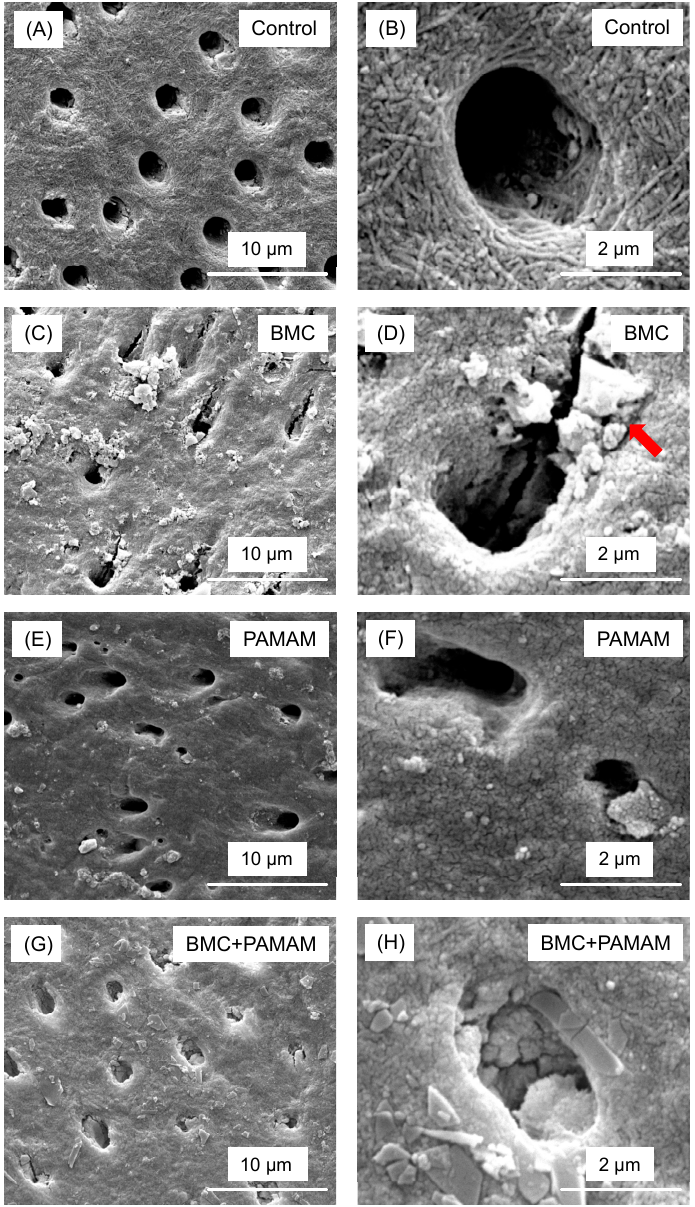
Figure 5. Representative SEM images of demineralized root dentin surface perpendicular to tubule axis after 21 days cyclic artificial saliva/lactic acid regimen: ( A , B ) control group, ( C , D ) BMC group, ( E , F ) PAMAM group, and ( G , H ) BMC + PAMAM group. Left column is at a lower magnification. Right column is at a higher magnification. Exposed collagen fibrils were detected in ( A , B ). ( C – F ) showed that regenerated minerals precipitated on the root dentin surface. Arrows showed minerals partially occluding the dentinal tubules. In ( G , H ), the dentin was covered by the remineralized mineral crystals. Representative SEM micrographs of root dentin parallel to the tubules are shown in Figure 6.